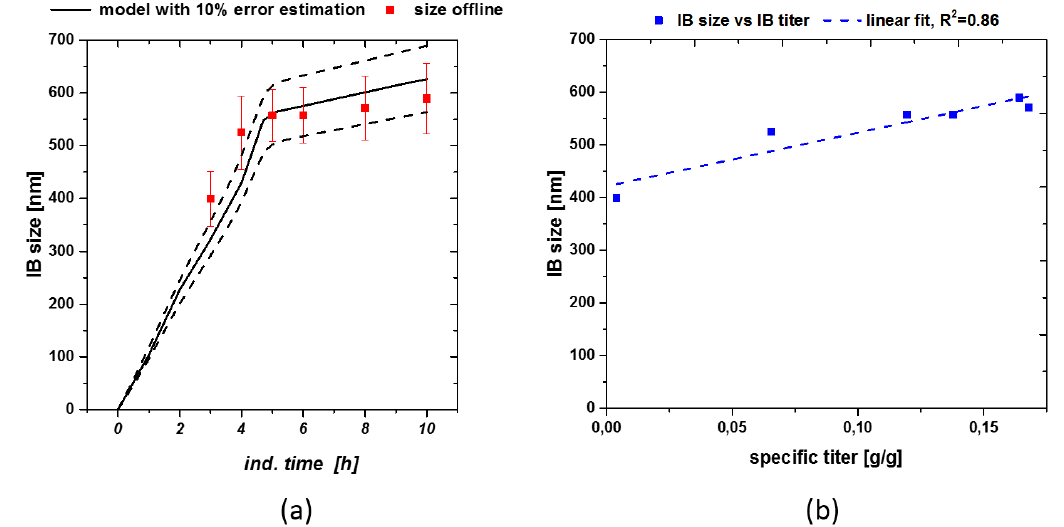
Figure 4. ( a ) Size modeling including real measured data with standard deviations. Especially early sizes could only be described using the model-based approach; ( b ) Size-titer correlation for fermentation with feeding strategy implied in Figure